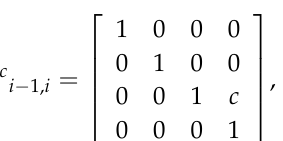
and the x -axis (max-displacement < 10.0 µ m), while the structure highlighted a high stiffness in the z -axis (max-displacement < 1.0 µ m). The simulation was used to estimate the coefficients of the regression